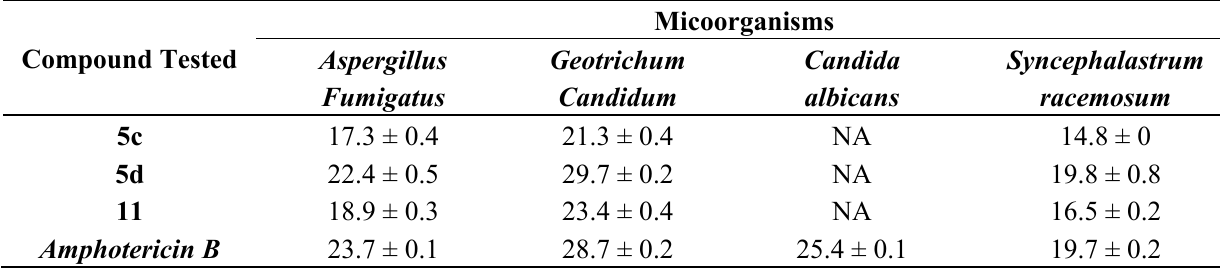
Table 1. Antifungal activities of the synthesized compounds 5c , d and 11